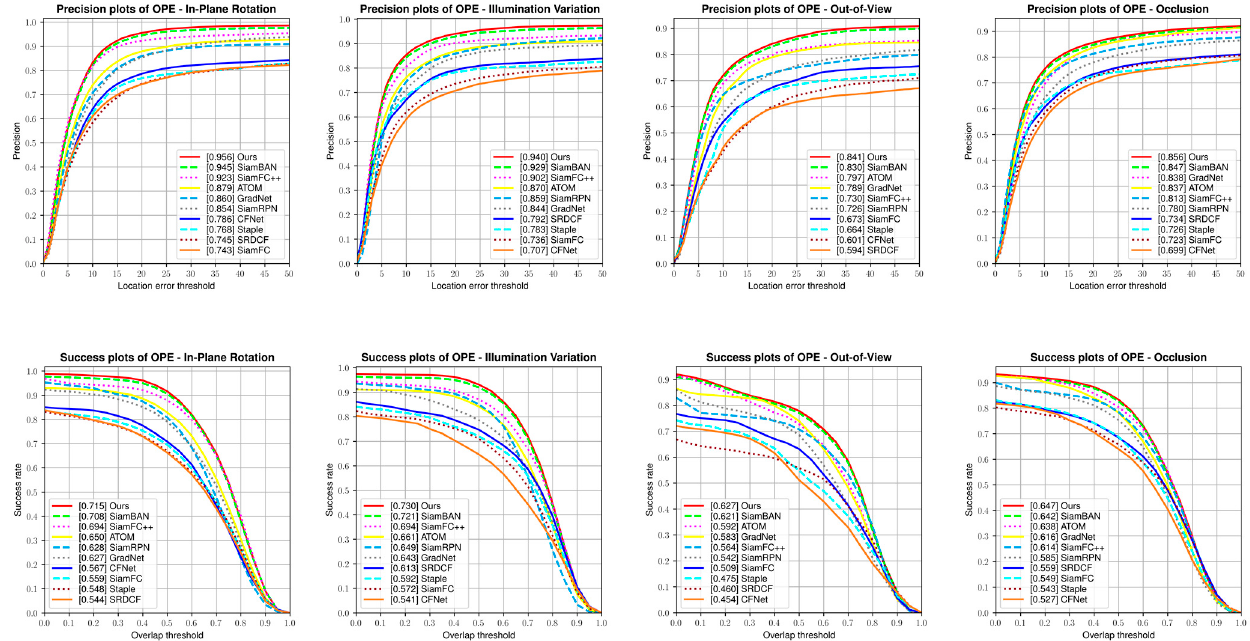
Figure 9. The evaluation on OTB100 dataset with four challenging attributes.